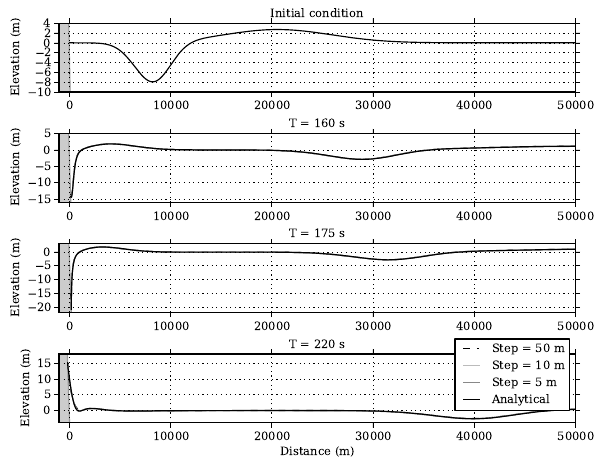
Fig. 3. Benchmark n. 1: initial and later sea surface profiles com- puted through the code UBO-TSUFD with different grid steps com- pared to analytical solutions. At this scale, all curves overlap. A more detailed comparison of the shoreline area is given in Fig. 5.